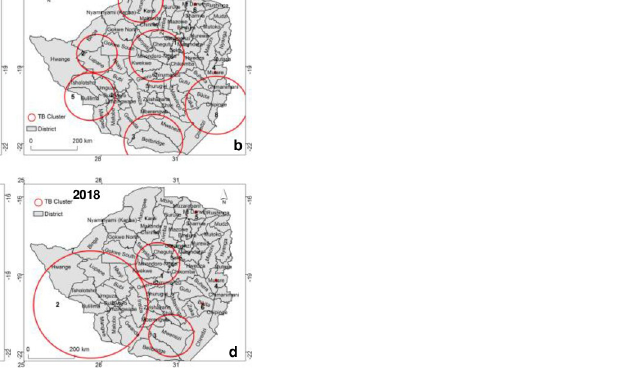
Fig 4. Spatial distribution of statistically significant primary and secondary TB clusters detected by purely spatial analysis based on the Gini coefficient for a) 2015, b) 2016, c) 2017 and d) 2018.